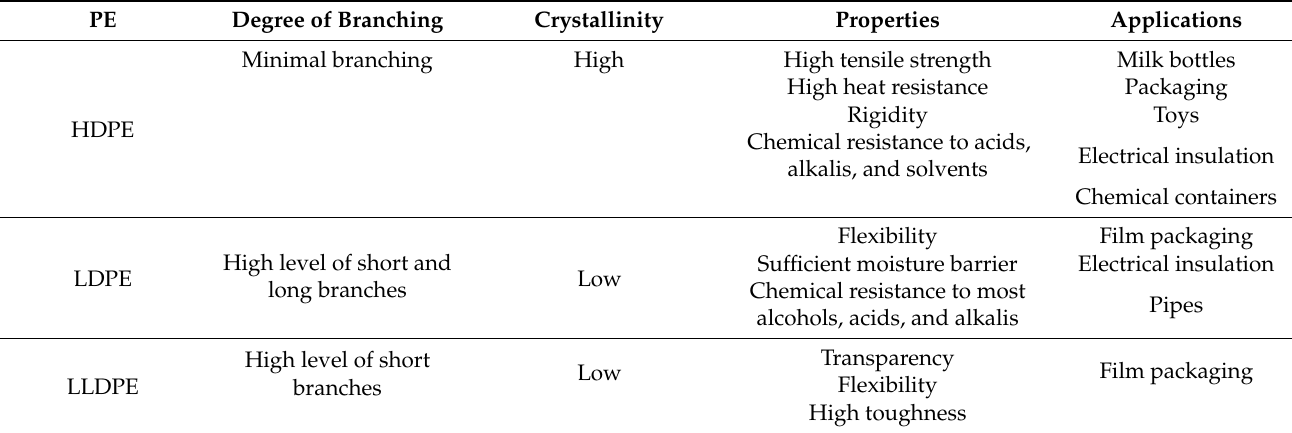
Table 1. Structure, properties, and applications of HDPE, LDPE, and LLDPE. The list of properties and applications is non-exhaustive [53,133,134,138,144–147].